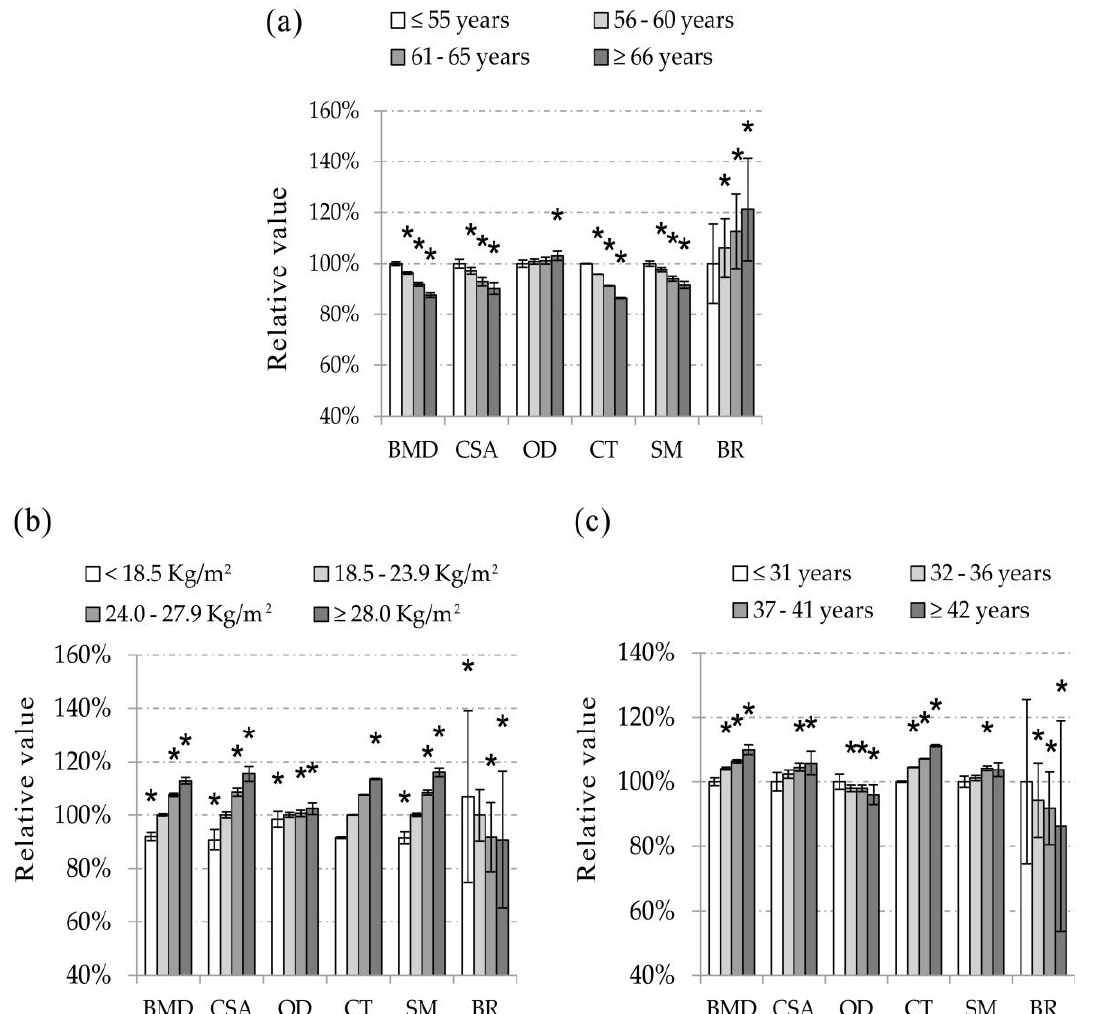
Figure 1. The relative values of bone mineral density (BMD) and Hip Structure Analysis (HSA) indices of each subgroup of age ( a ); BMI ( b ) or years of menstruation ( c ) to the reference group at narrow neck (NN). The values were expressed as percent relative to the group of age ≤ 55 years, BMI = 18.5–23.9 kg/m 2 and years of menstruation ≤ 31 years, respectively. Values were adjusted for height, age at menarche, total daily physical activity, education, smoking status and calcium tablet intake. In addition, when age, BMI or years of menstruation was analyzed, two of the variables, i.e. , age, weight and years of menstruation, were also adjusted as covariates in the analysis. Vertical bars represent the standard errors of the mean value. * p < 0.05 vs. the reference group; NN, narrow neck; BMD, bone mineral density; CSA, cross ‐ sectional area; OD, outer diameter; CT, cortical thickness; SM, section modulus; BR, buckling ratio.